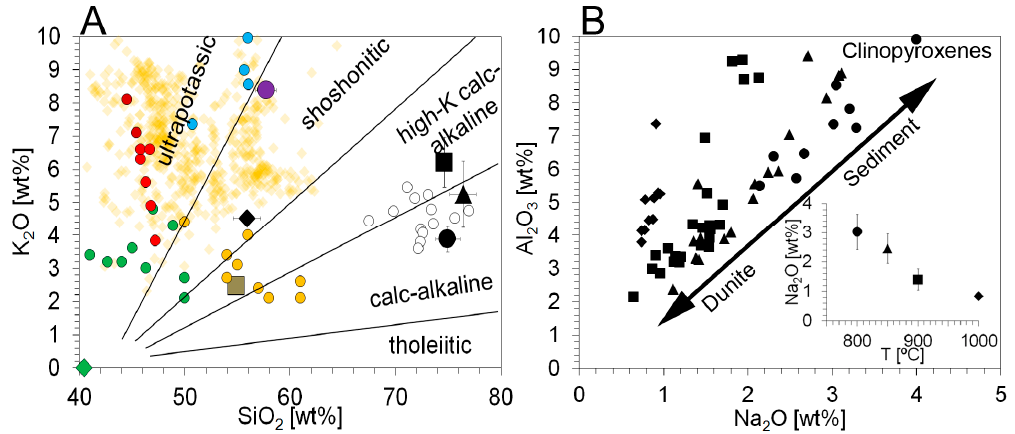
Figure 2. Melt ( A ) and clinopyroxene ( B ) compositions from reaction experiments (black circle 800 ◦ C; triangle 850 ◦ C; square 900 ◦ C; diamond 1000 ◦ C) and second-stage melts (purple circle) of this study, compared with the sedimentary rock starting material (brown square), and published data: melts of phlogopite harzburgite and lherzolite (dark red and red circles [15]), hybridized rhyolite–peridotite (green circles [18]), glimmerite–harzburgite (blue circles [16]), hybridized phyllite–dunite (open white circles [20,31]), and phlogopite–amphibole peridotite (orange circles [55]). Natural post-collisional lavas with K / Na > 2 (yellow diamonds [9]) are shown for comparison. Melts from reaction experiments at 3 GPa / 800–1000 ◦ C are SiO 2 -rich and have moderately high K 2 O. In contrast, second-stage experiment melts (purple dot) have higher K 2 O and lower SiO 2 , similar to natural ultrapotassic (UP) magmas. (B) Clinopyroxenes from reaction experiments show a range of compositions across the reaction zone, with higher Na 2 O and Al 2 O 3 towards the former sedimentary rock. Symbols correspond to the experimental temperatures as in (A).